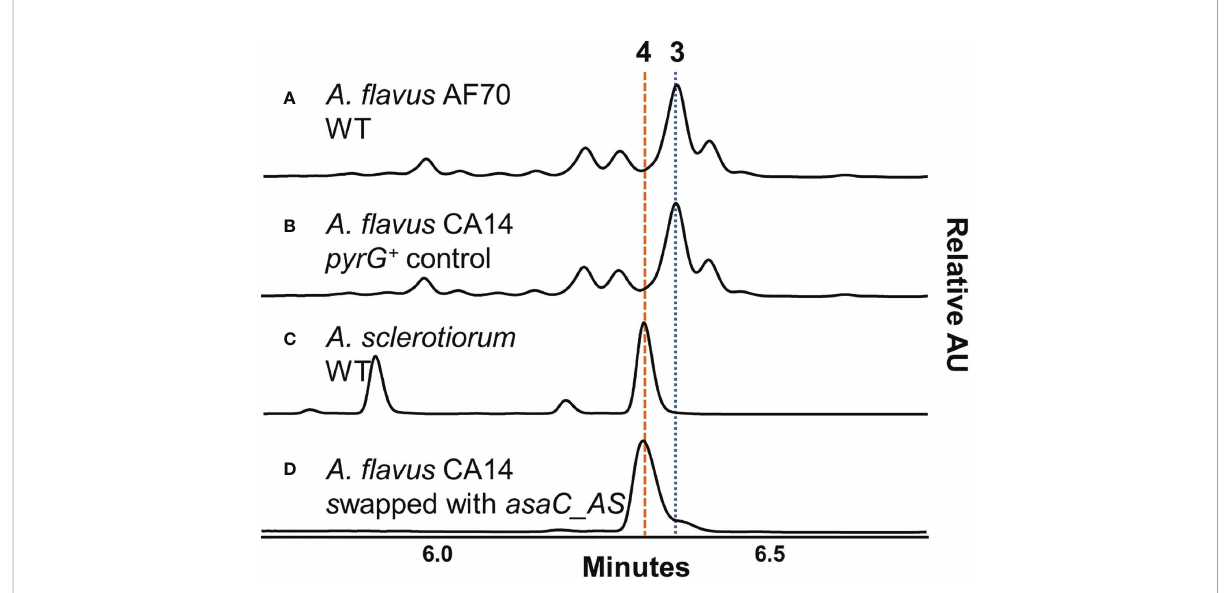
FIGURE 3 A. fl avus containing asaC from A. sclerotiorum produces an iron(III)-bound trimer found naturally only in Aspergillus section Circumdati species. (A – D) UV chromatograms of Aspergillus extracts grown on AFPA measured in relative absorbance units (AU) at l = 310